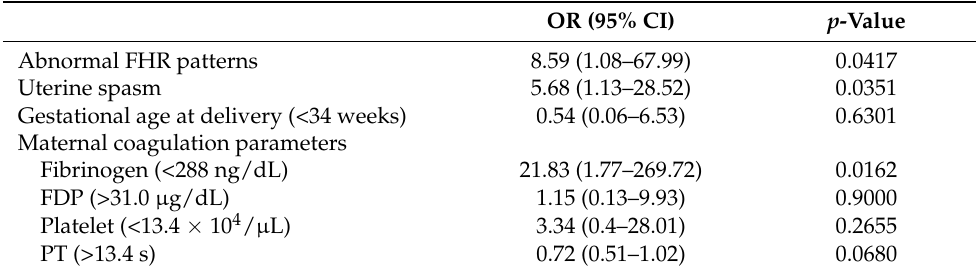
Table 3. Results of multiple logistic regression analysis in terms of prediction of fetal acidemia.